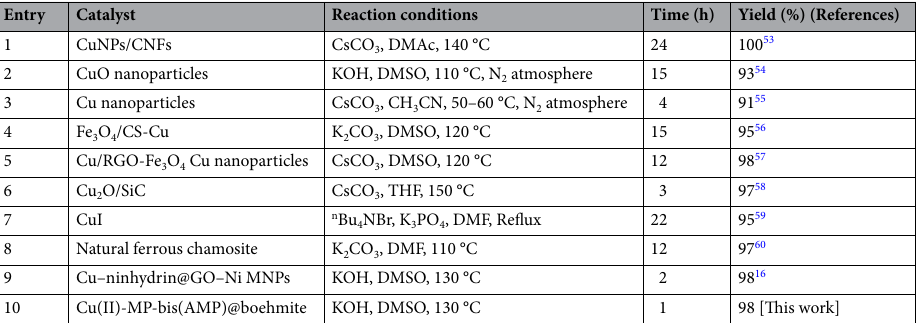
Table 7. Comparison results of Cu(II)-MP-bis(AMP)@boehmite catalyst with other reported catalysts in the synthesis of biphenyl